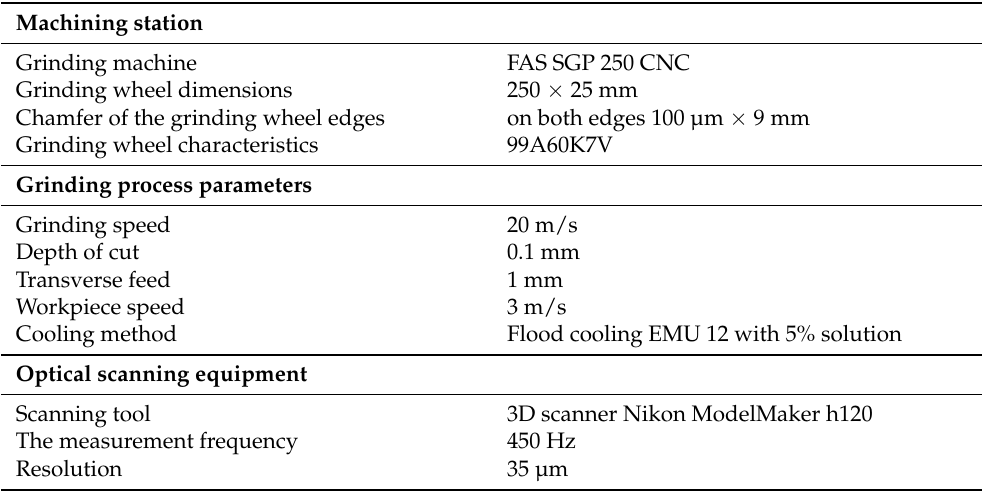
Figure 4. The shape of the layered grinding wheel used in the experimental tests. Table 1. Conditions and parameters of grinding